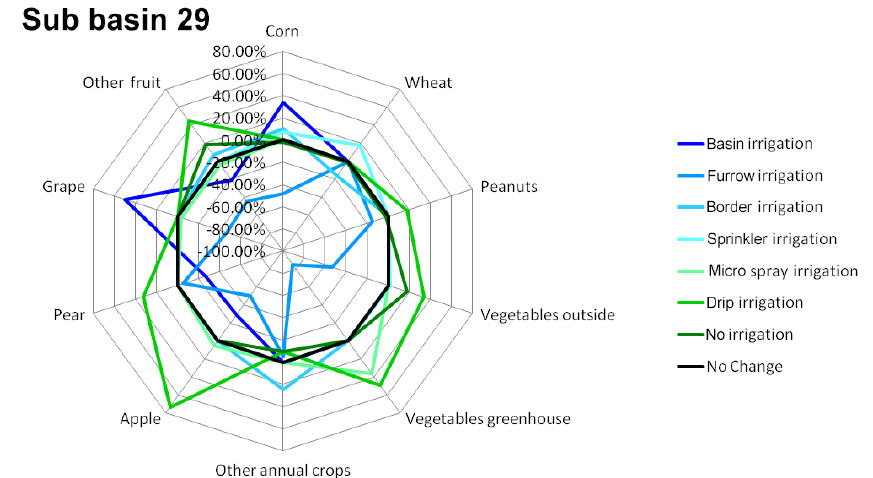
Figure 6. Proposed irrigation changes for sub basin 29, optimised to reduce the irrigation water demand whilst retaining the overall basin yield, according to local soil